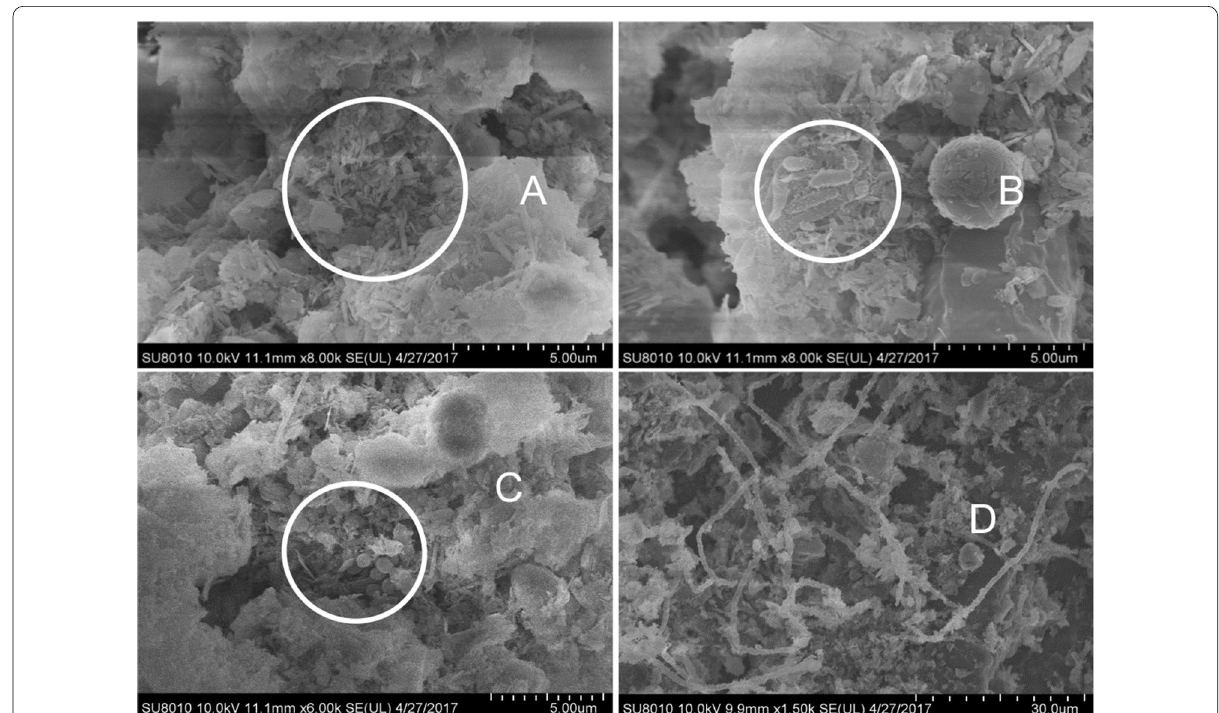
Fig. 1 Scanning electron microscope observation of the surface and internal structure of HTPB sample with bacterial membrane attached (Pictures A and B show the rod‑shaped bacteria in corroded HTPB material. C Shows the corrosive cocci in the HTPB material. D Shows the hypha structure cross‑linked with